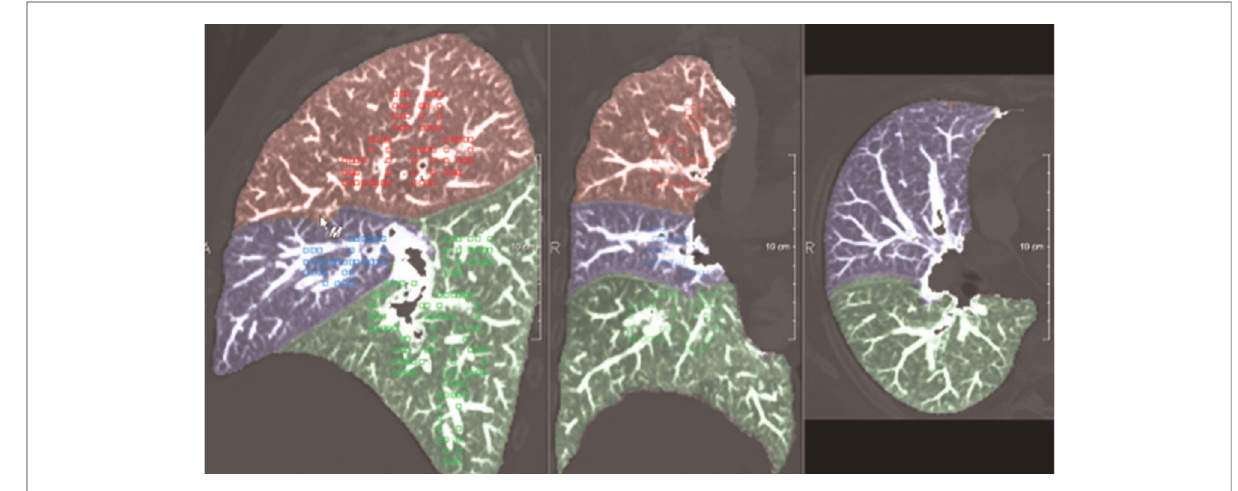
FIGURE 4 Automatically identi fi ed lung lobes.